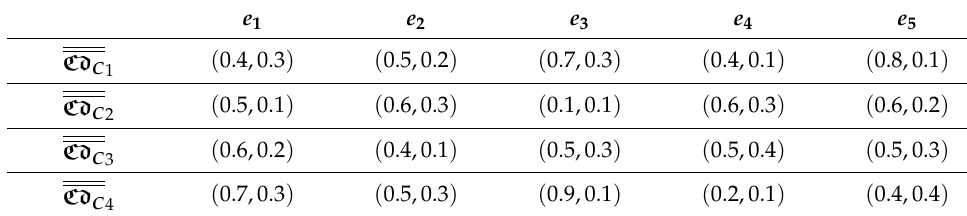
Table 2. Intuitionistic fuzzy soft matrix for Cd A 2 .